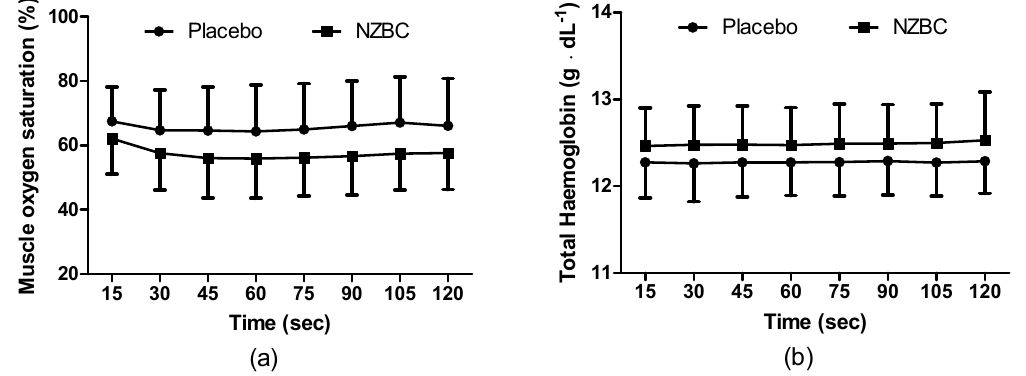
Figure 3. ( a ) Muscle oxygen saturation; ( b ) total haemoglobin concentration during a 120-s 30%iMVC of the quadriceps muscle for placebo and after 7-days intake of NZBC (New Zealand blackcurrant) extract capsules. Data are mean ± SD. * difference between placebo and NZBC extract.